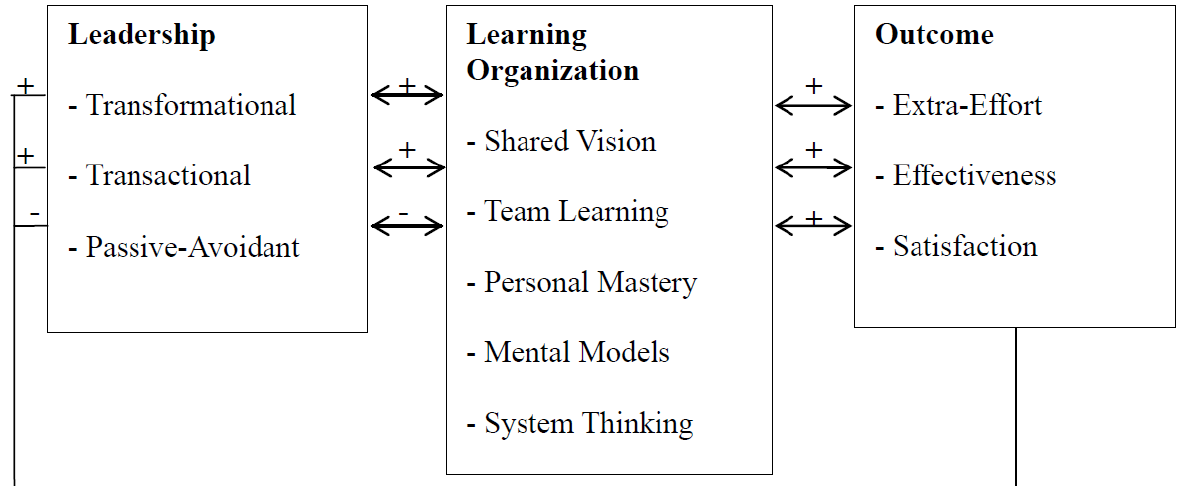
Figure 1. Synoptic scheme of